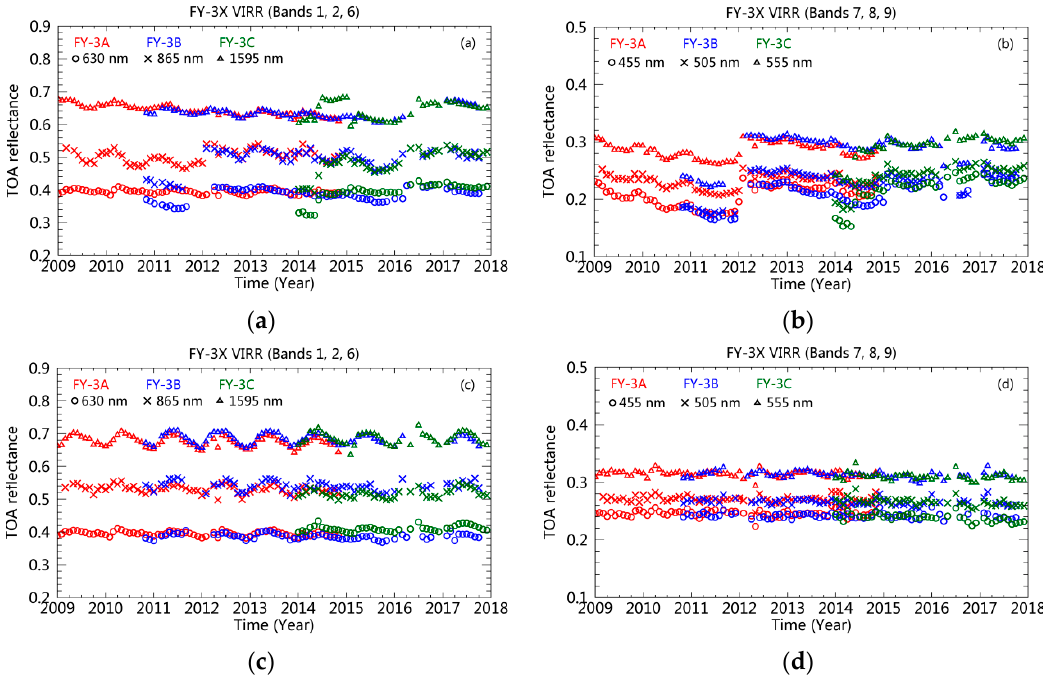
Figure 9. Time series of the nadir (viewing angle within 10 ◦ ) reflectance data in RSBs over Libya 4 from January 2009 to December 2017. ( a , b ) Operational calibration results; ( c , d ) recalibrated results using the MST calibration